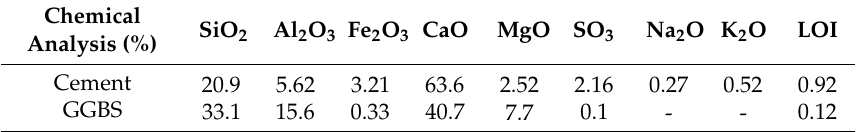
Table 1. Chemical analysis of cement and ground granulated blast furnace slag (GGBS).